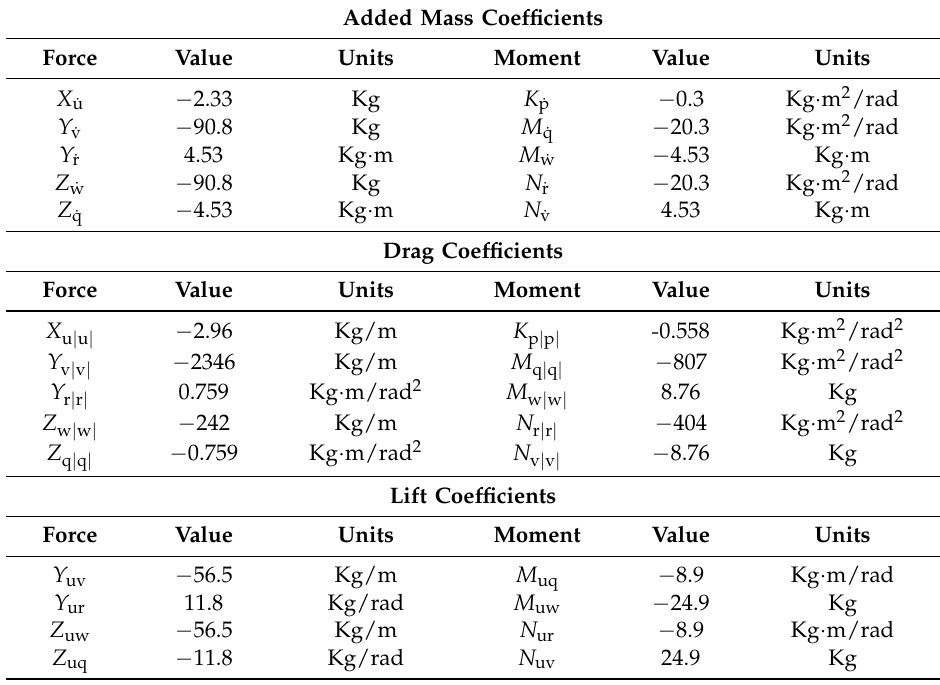
Table A1. The list of AUV